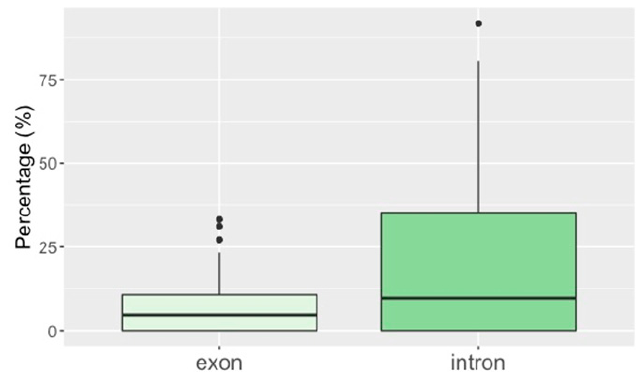
Figure 2. Box plots of intron and exon abundance. The frequency of introns and exons were calculated as % of total fosmid lengths. Boxes contain the interquartile range from the 25th to the 75th percentile, the horizontal line indicates the median, and vertical lines indicate minimum and maximum distributions of the data. Outliers are shown by dots.